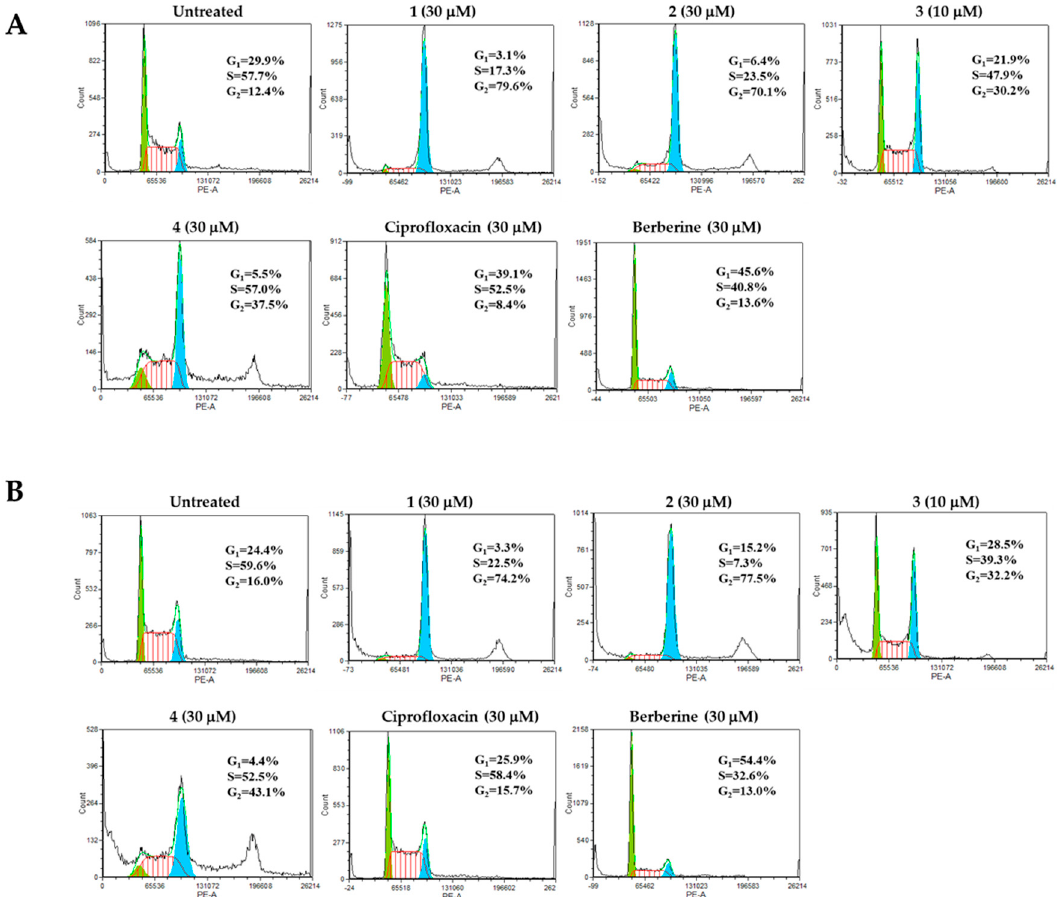
Figure 7. Analysis of cell cycle distribution of HL-60 cells treated with indicated concentrations of berberine, ciprofloxacin and berberine derivatives 1–4 for 24 h ( A ) and 48 h ( B ).